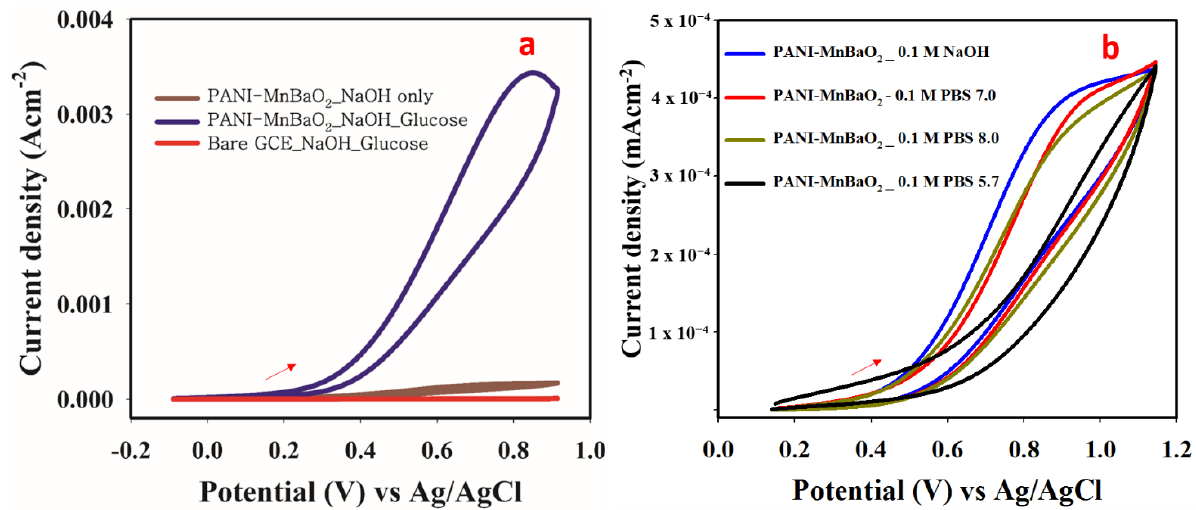
Figure 5. ( a ) Cyclic voltammogram obtained in a solution containing 20 mM glucose and 0.1 M NaOH.at a scan rate of 75 mV/s. ( b ) Cyclic voltammogram obtained in a solution containing 0.2 mM glucose and different pH / supporting electrolyte.